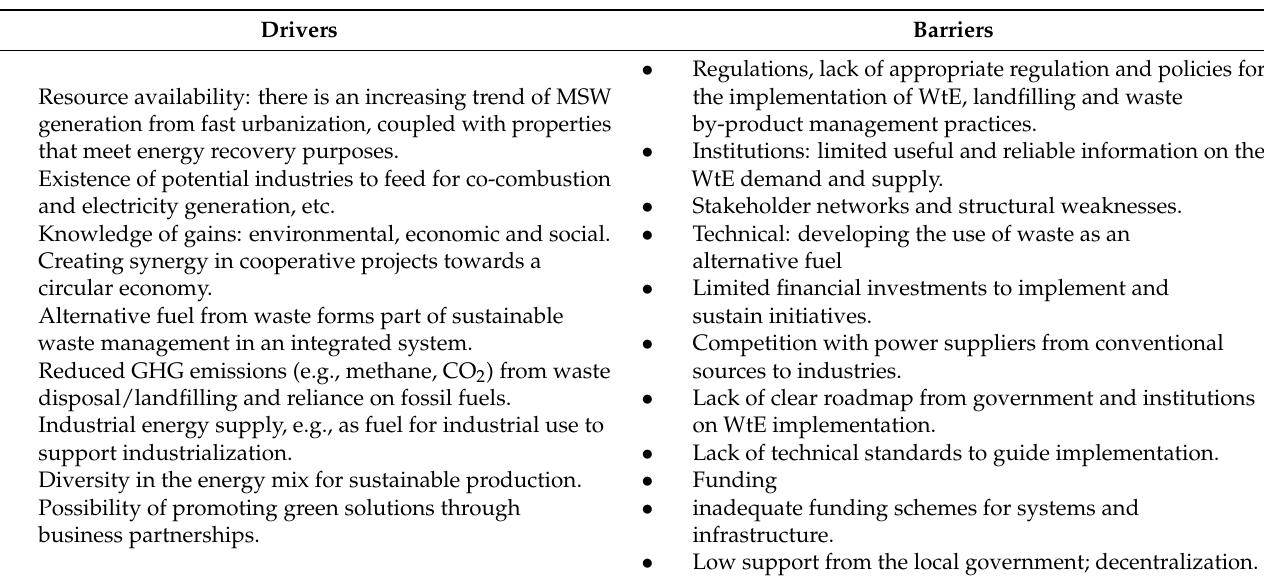
Table 7. Analysis of barriers and drivers for alternative fuel from